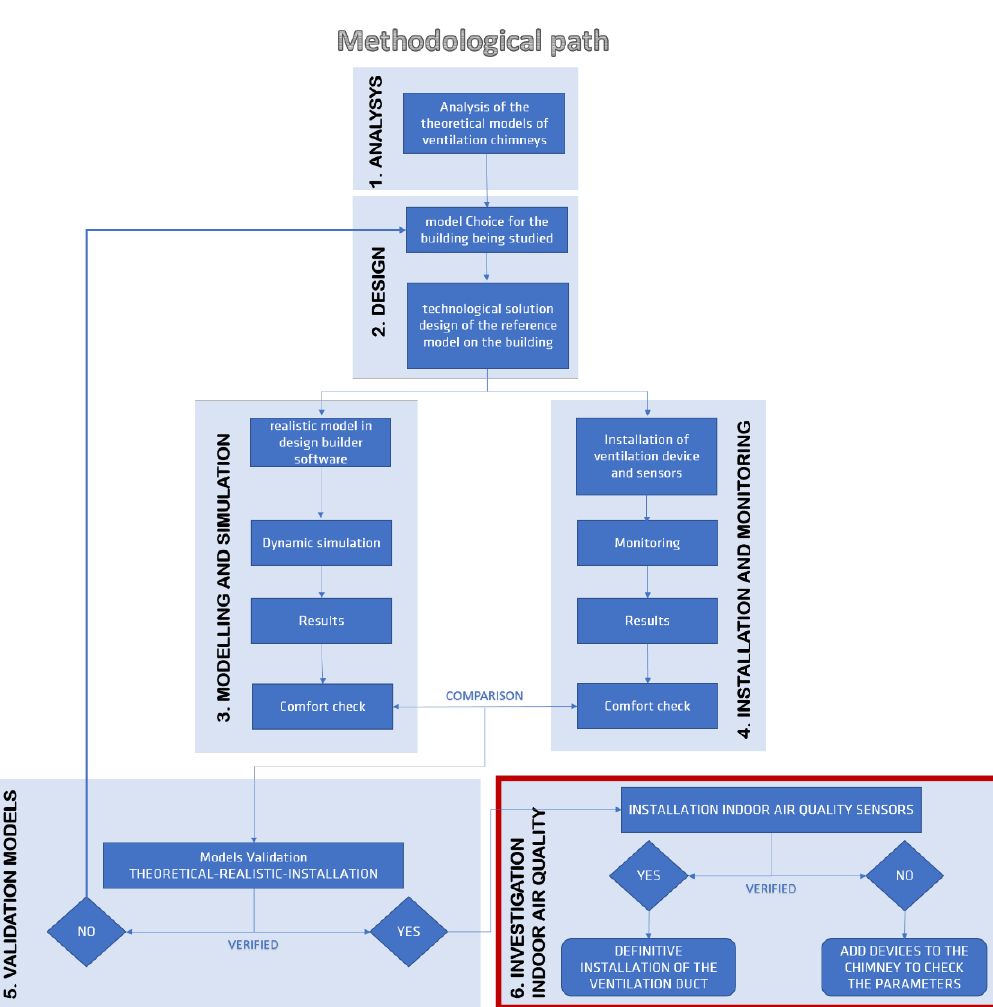
Figure 1. Flow chart of the research methodology . The part of the research covered by this text is in red.